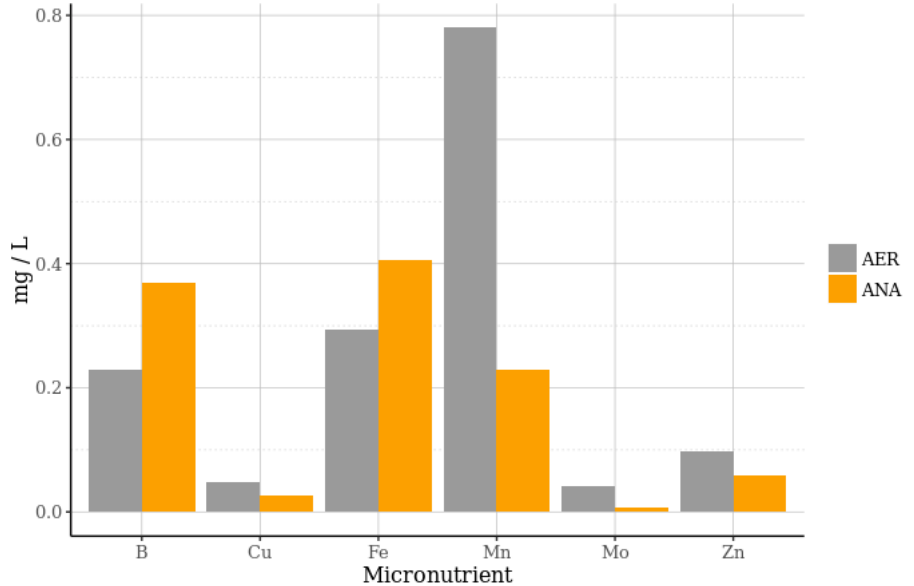
Figure 5. Micronutrients of the undiluted AER and ANA supernatant additives at the beginning of the experiment.